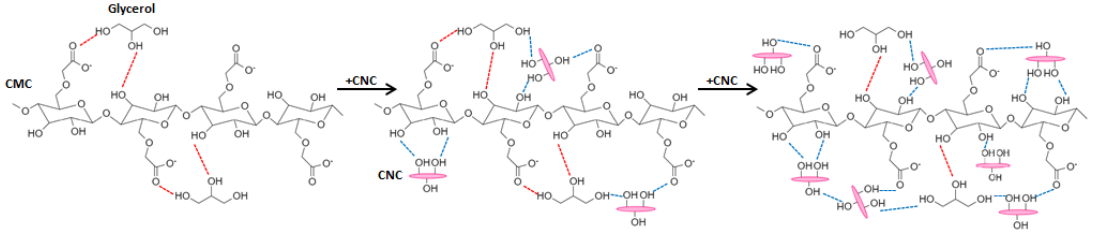
Scheme 1. Representation of possible interactions between CMC, G, and CNC.